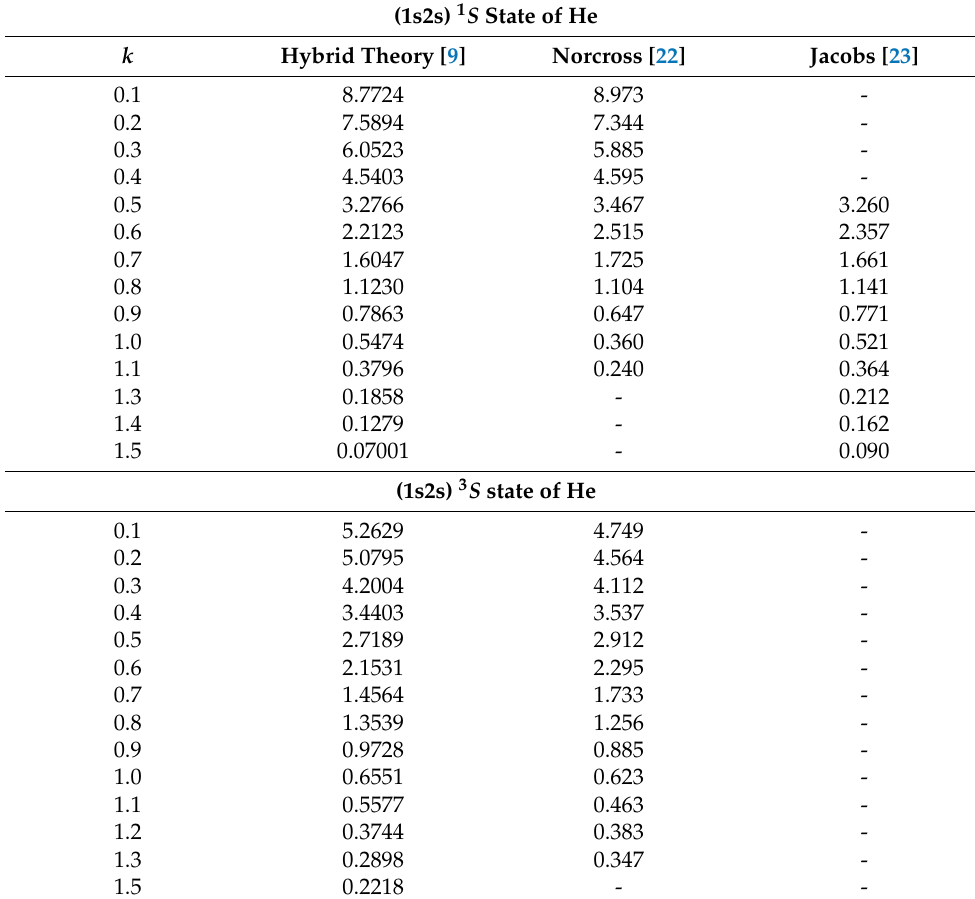
Table 3. Photoionization cross sections (Mb) for the metastable states of He.